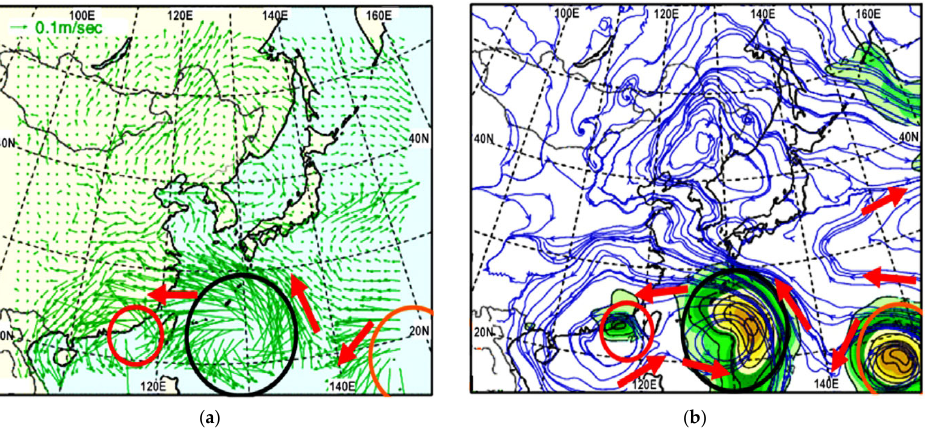
Figure 18. As shown in Figure 3, except for ( a ) surface pressure analysis (hPa) and ( b ) COMS ‐ IR satellite image, at 09:00 LST, 9 July. In ( b ), MLCT indicated (center right), Typhoon Linfa just before landfall, and TY Chan ‐ Hom cloud interaction with TY Nangka.